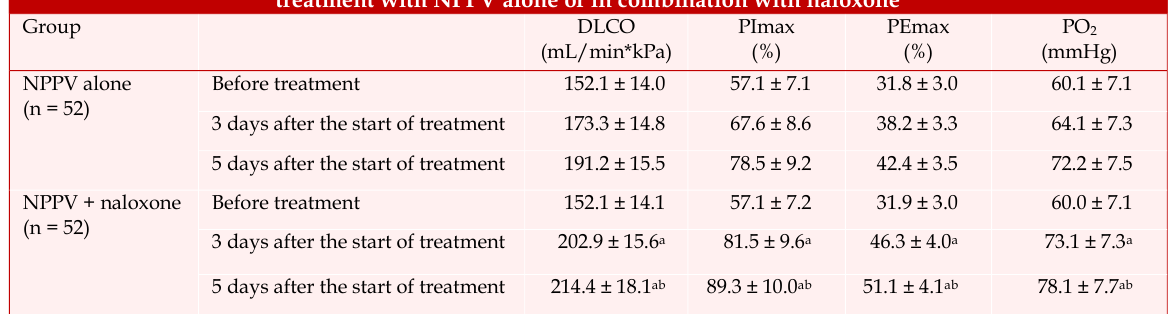
Pulmonary gas exchange measurements in patients with COPD-related respiratory failure before and after treatment with NPPV alone or in combination with naloxone